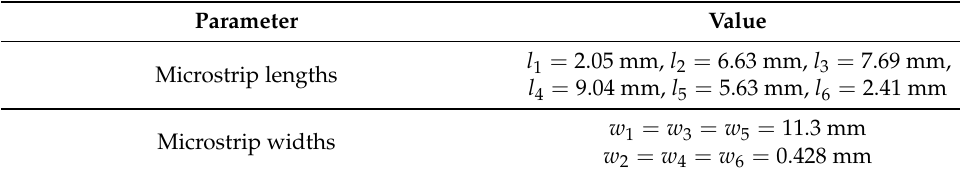
Table 1. Microstrip low-pass filter geometrical